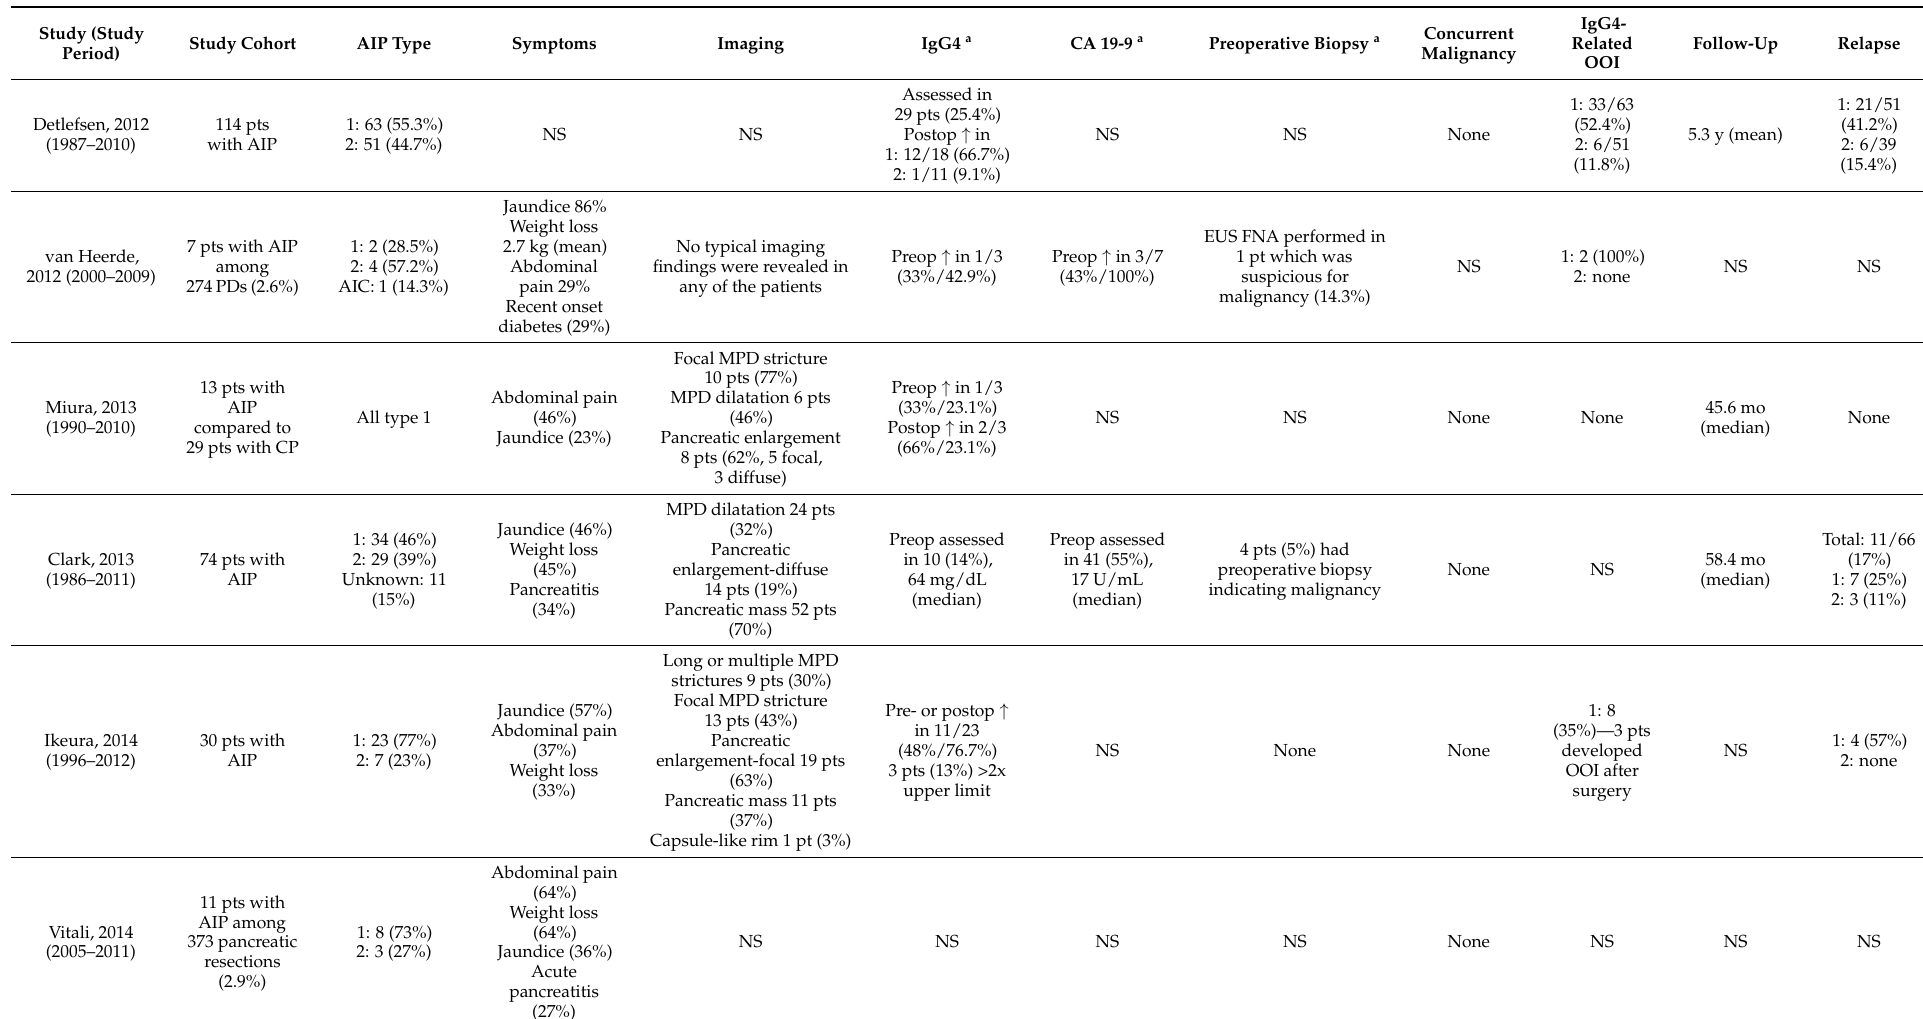
Table 1. Review of studies published in the last decade regarding patients with autoimmune pancreatitis after pancreatic